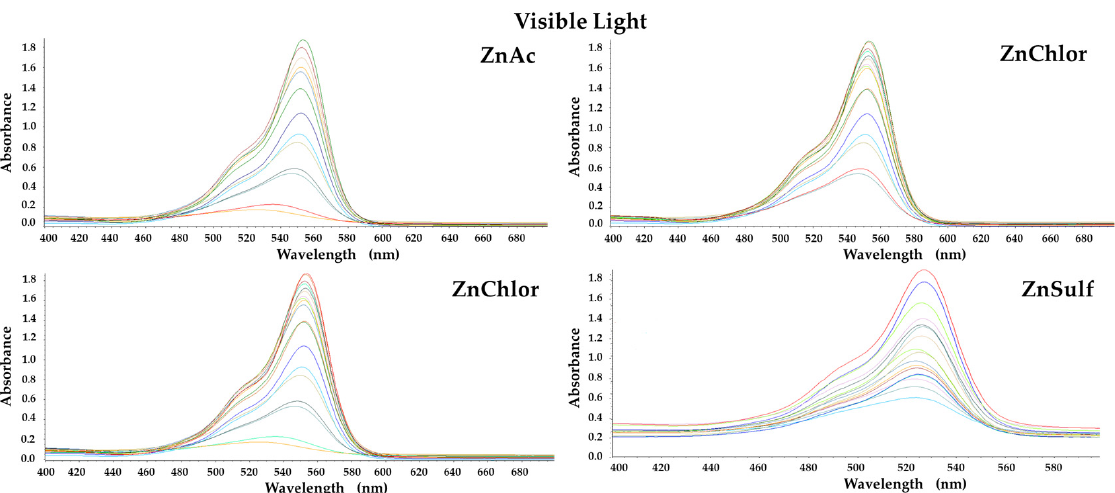
Figure 9. Real time UV–Visible spectra under visible light photocatalytic degradation of Rhodamine B, by the four ZnO powders, produced by different precursors.